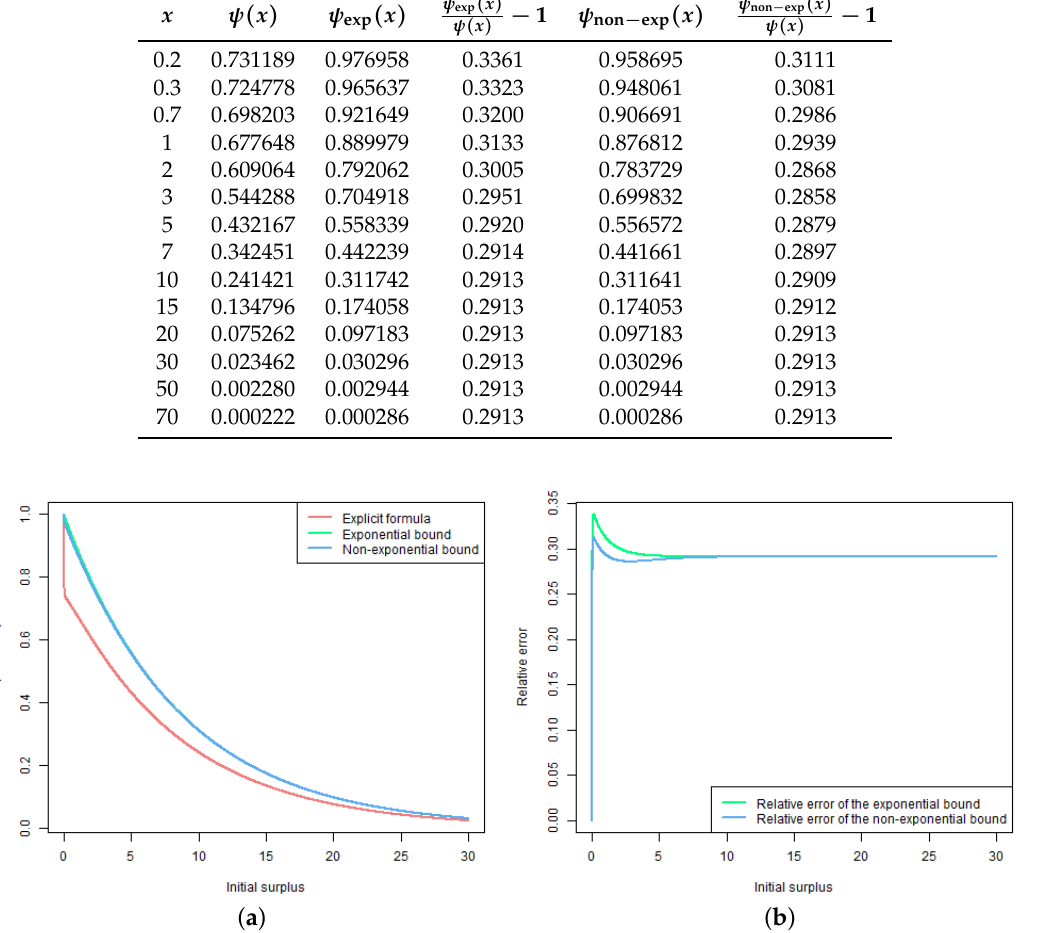
Figure 5. Comparison of the results for the model considered in Example 5: ( a ) Ruin probability given by the explicit formula as well as the exponential and non-exponential bounds for it. ( b ) Relative errors of the exponential and non-exponential